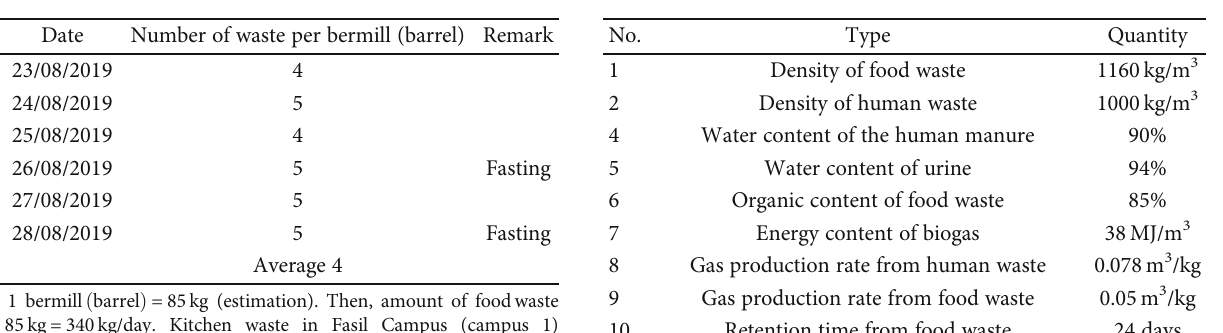
Table 2: Recorded food waste per day for six consecutive days at campus 1.